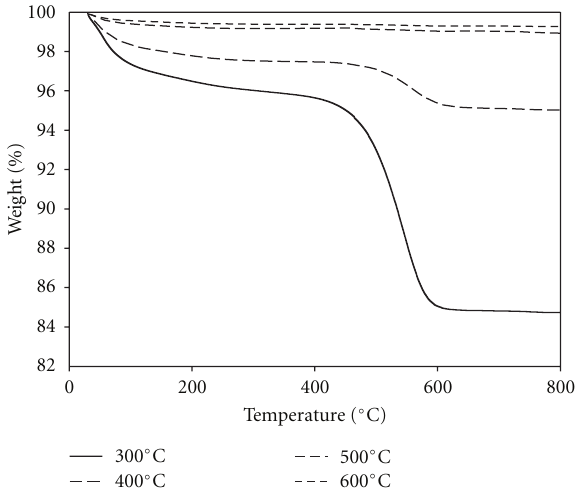
Figure 3: Thermogravimetric analysis of MWNT-TiO 2 at four di ff erent calcination temperatures (300, 400, 500, and 600 ◦